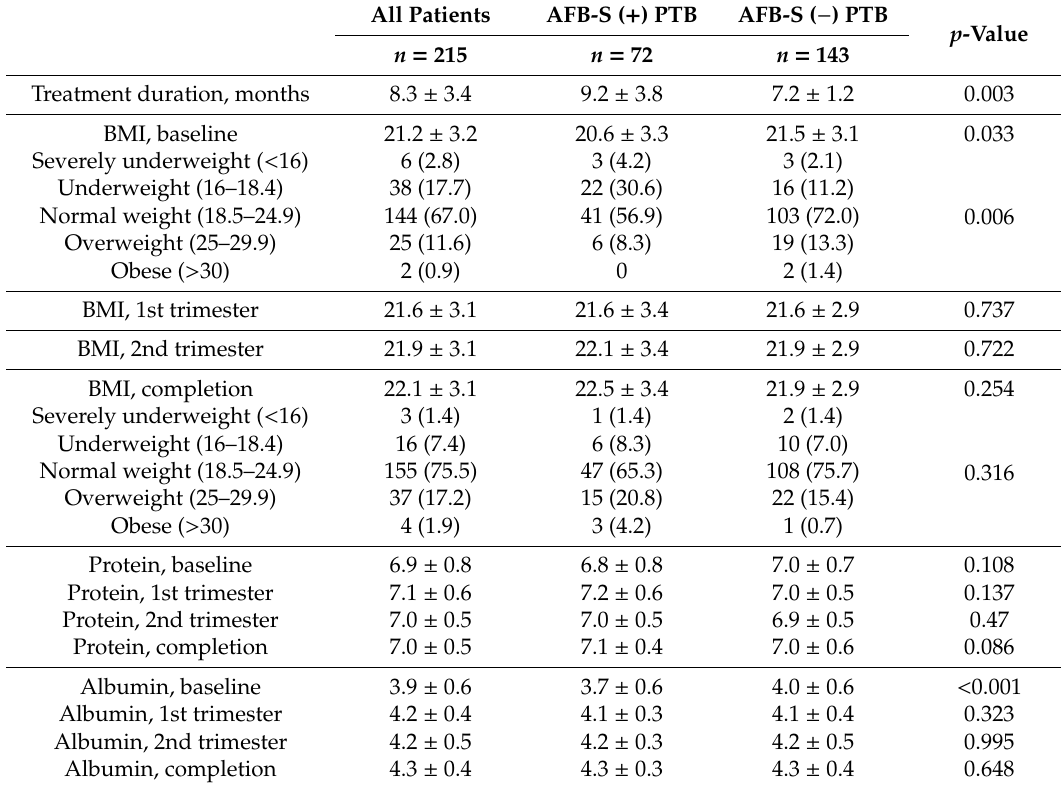
Table 3. Sequential changes of the nutritional status in enrolled 215 cases after anti-TB treatment. All